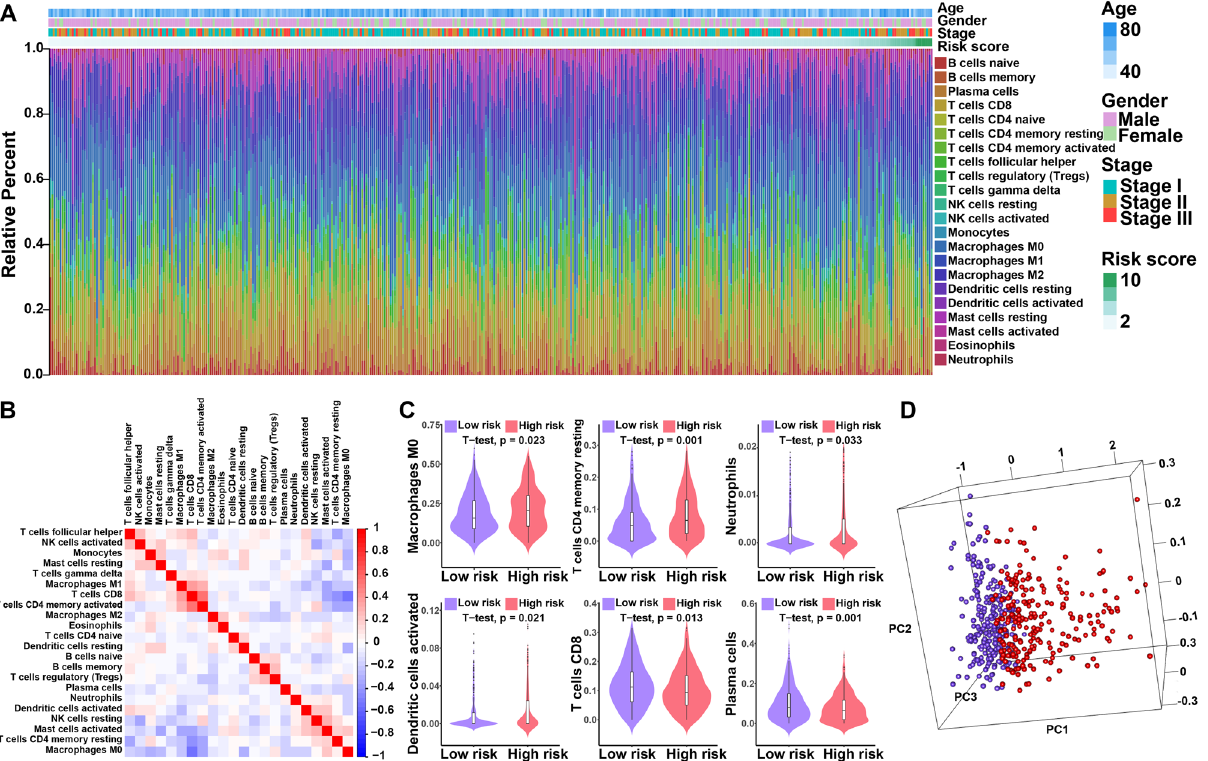
Figure 2. Characterization of immune infiltration in high- and low-risk LUSC patients. ( A ) The relative proportion of 22 infiltrated immune cells in LUSC. ( B ) Correlation analysis among each immune cell proportions. ( C ) Violin plots of distribution of significantly different cell subtypes. Significances were measured using the unpaired t-test. ( D ) Principal components analysis based on the above significantly different immune cells between high- and low-risk LUSC